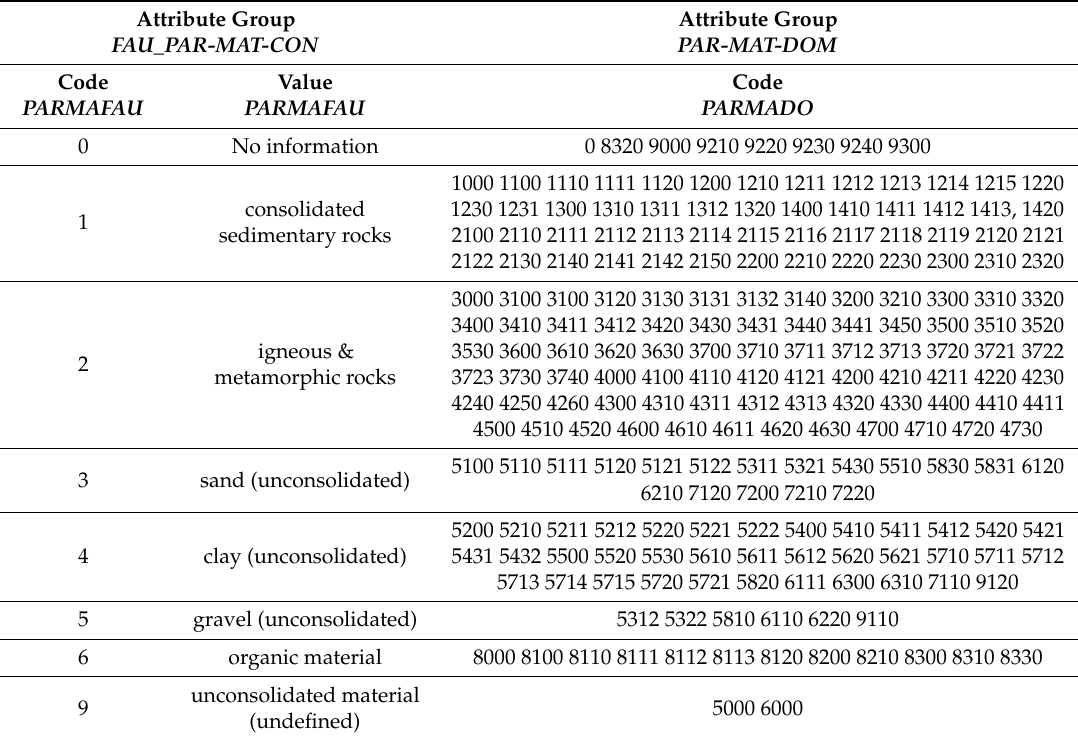
Table 4. Relationship between codes of FAU_PAR-MAT-CON and